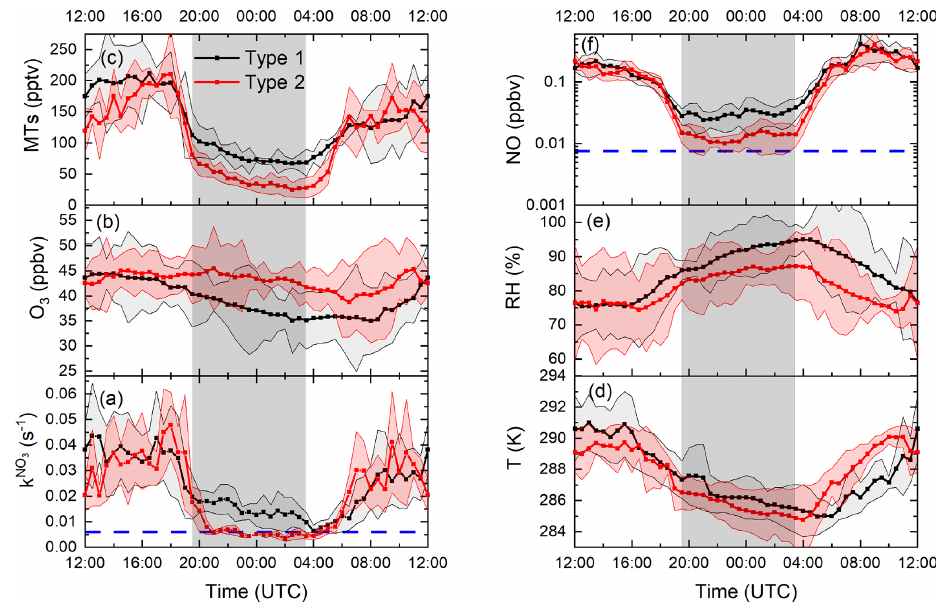
Figure 3. Median diel profiles of (a) directly measured NO 3 reactivities, (b) O 3 mixing ratios, (c) monoterpenes, (d) temperature, (e) relative humidity, and (f) NO mixing ratios classified by night types (Type 1 in black; Type 2 in red). The grey shaded area represents the nighttime period. The shaded areas in line colour represent the 25th and 75th percentiles. The blue lines denote the LODs of the instruments used to measure NO 3 reactivity and